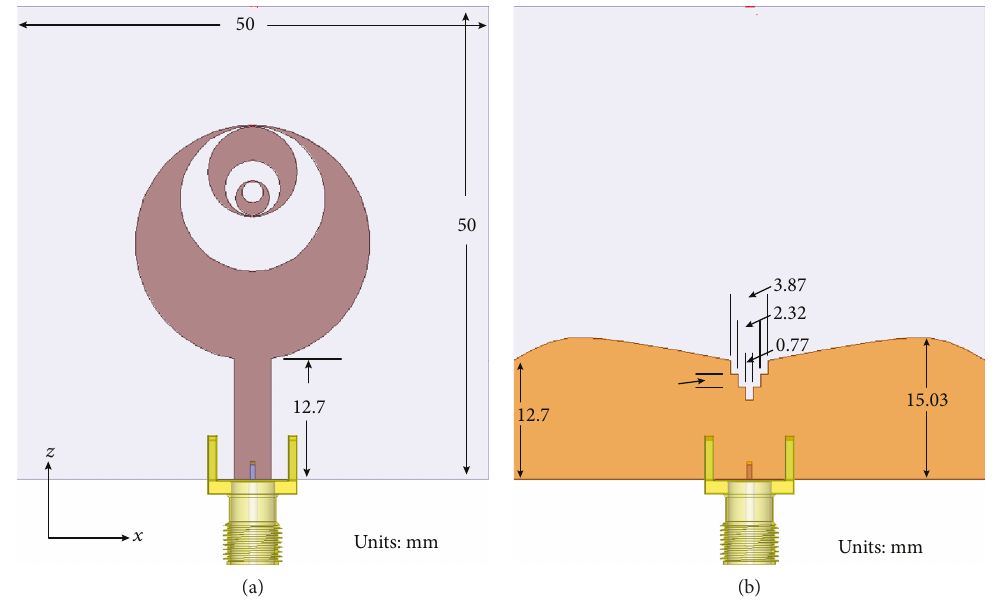
Figure 5: Proposed con fi guration with inscribed fractal Fibonacci circles, beveling, and Kraus technique: (a) front view and (b) back view.